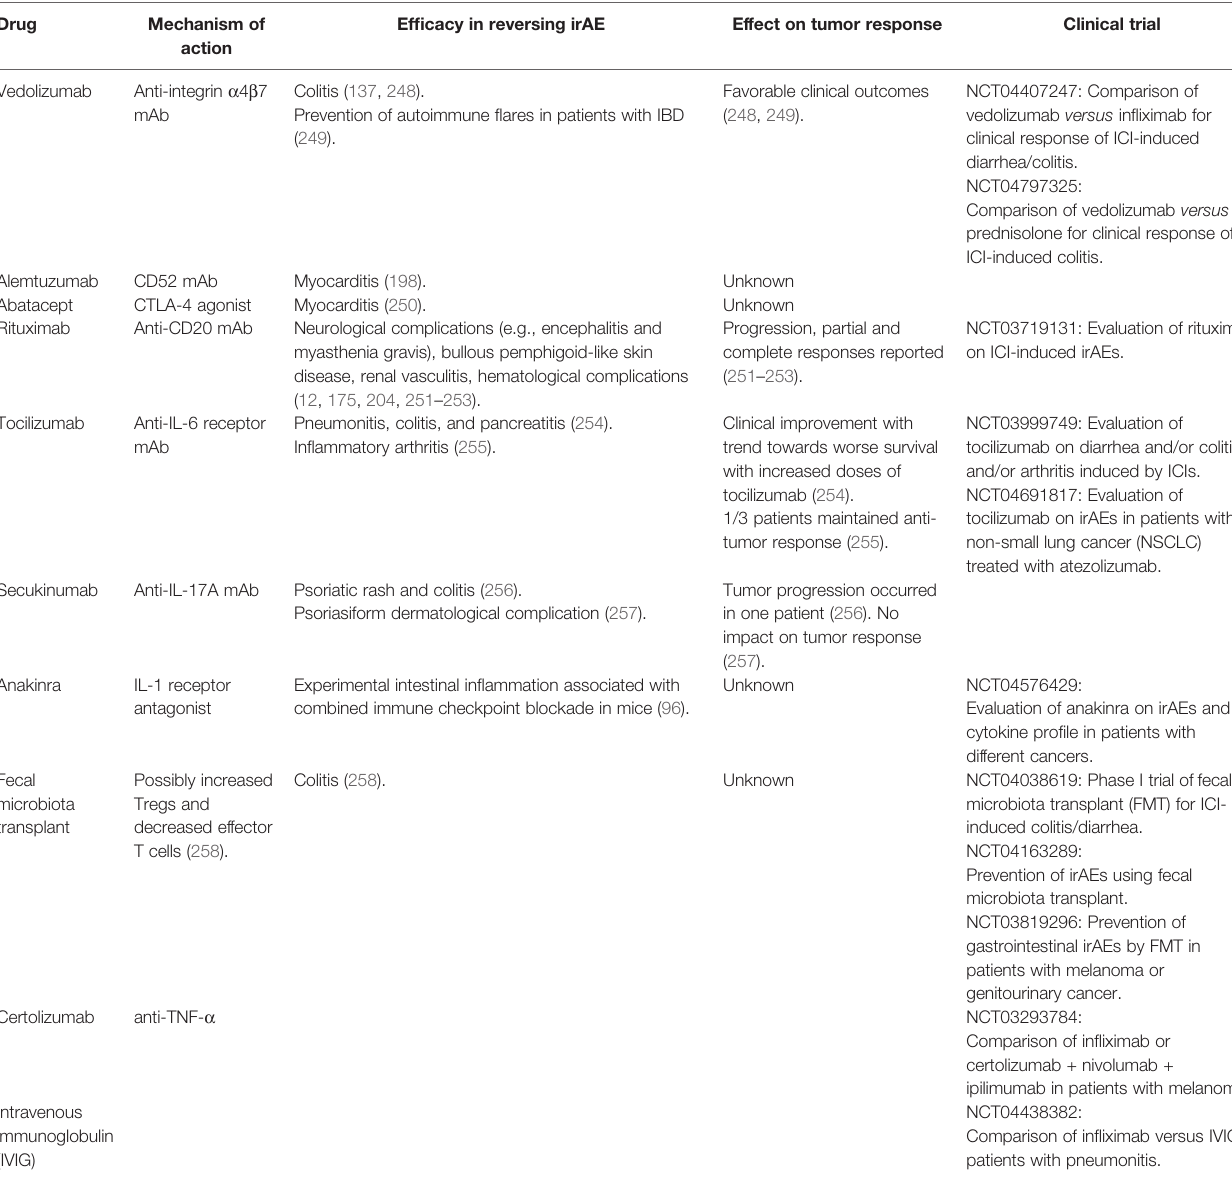
TABLE 3 | Emerging and potential future therapies for immune adverse events associated with immune checkpoint